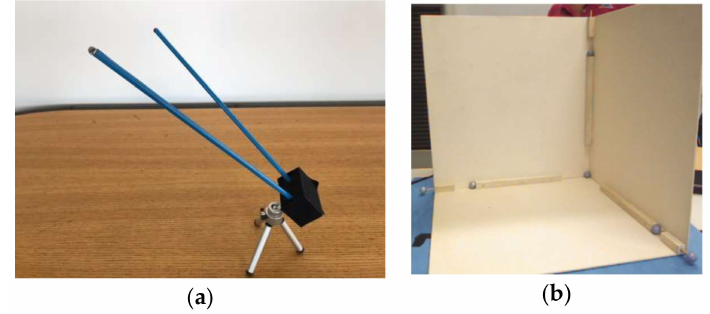
Figure 5. Calibration tools: ( a ) V-shaped tool; ( b ) Dihedral